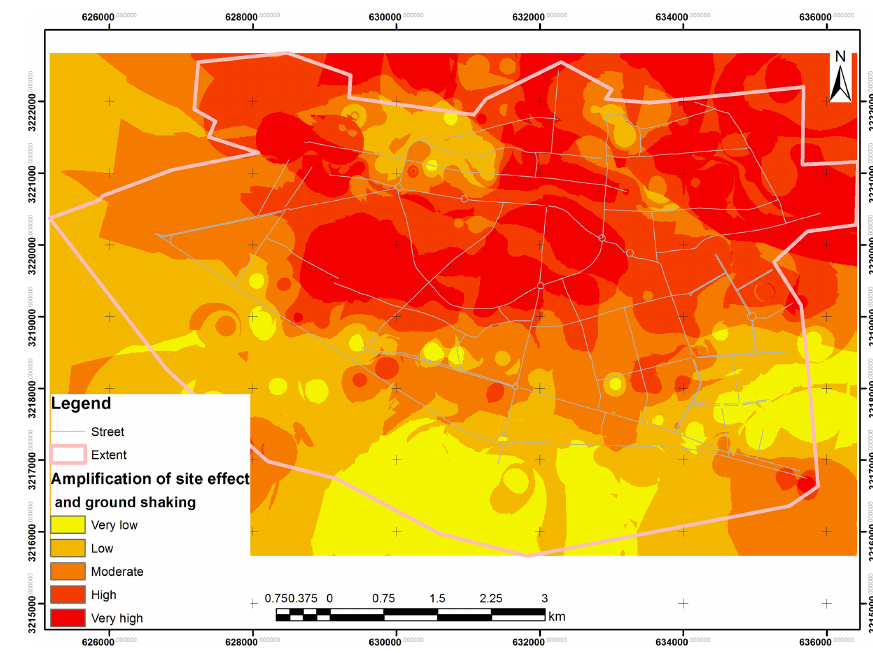
Figure 13. Susceptibility map of local seismic amplification of Bam City.